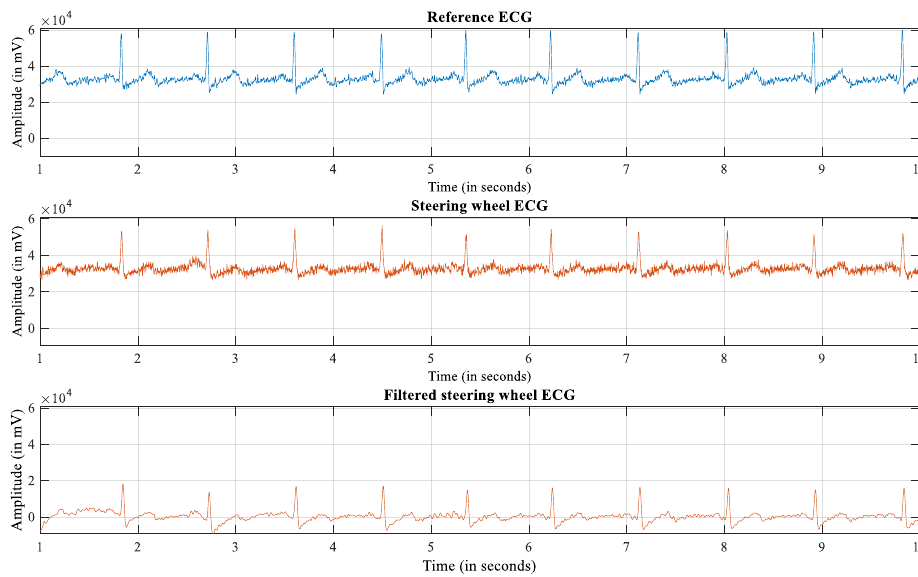
Figure 3. ECG recordings during rest.